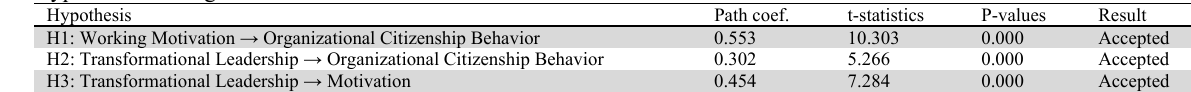
Hypothesis Testing